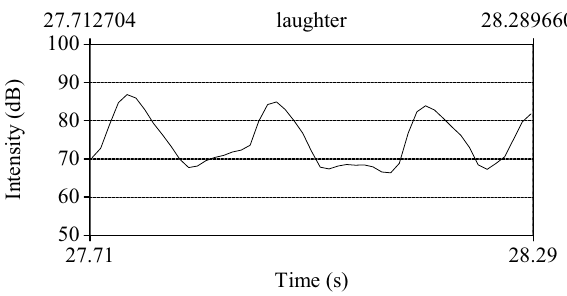
Figure 7: Weak laughter after agentive - initiated perspective of evaluation ( line 58 )